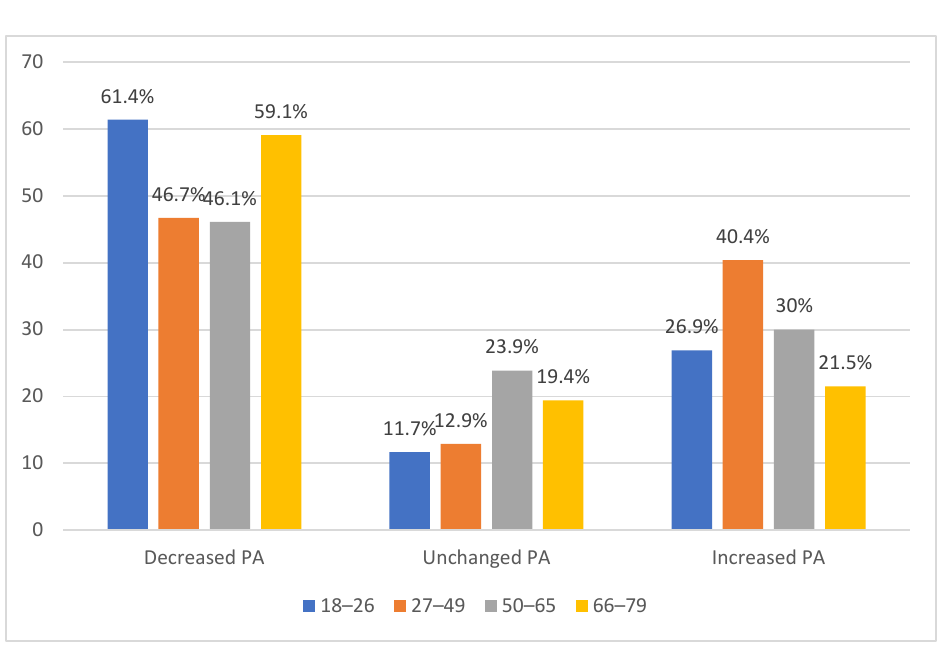
Figure 1. Proportion of participants reporting decreased, increased, or unchanged total PA. Note: No significant difference existed between men and women, χ 2 (2) = 1.251 ( p > 0.05).